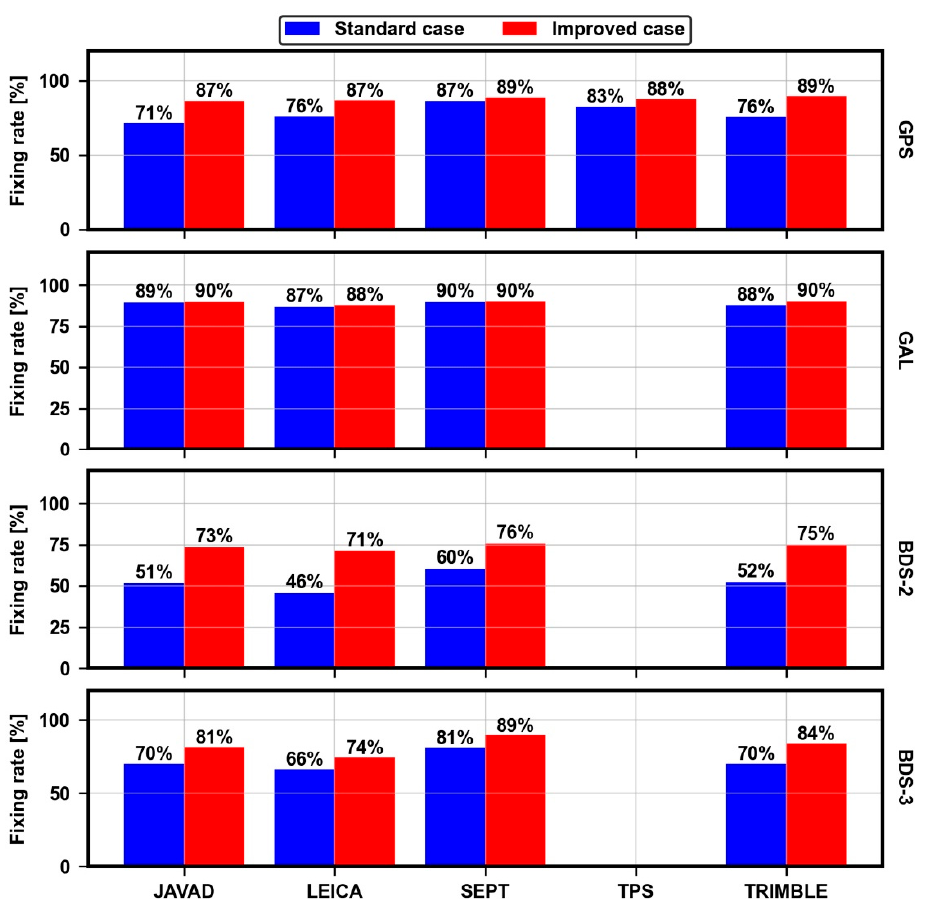
Figure 9. WL ambiguity fixing rates of each receiver type for the standard case and improved case for the Case 4 network.